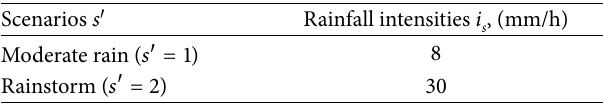
Table 9: Network scenarios and corresponding intensities.